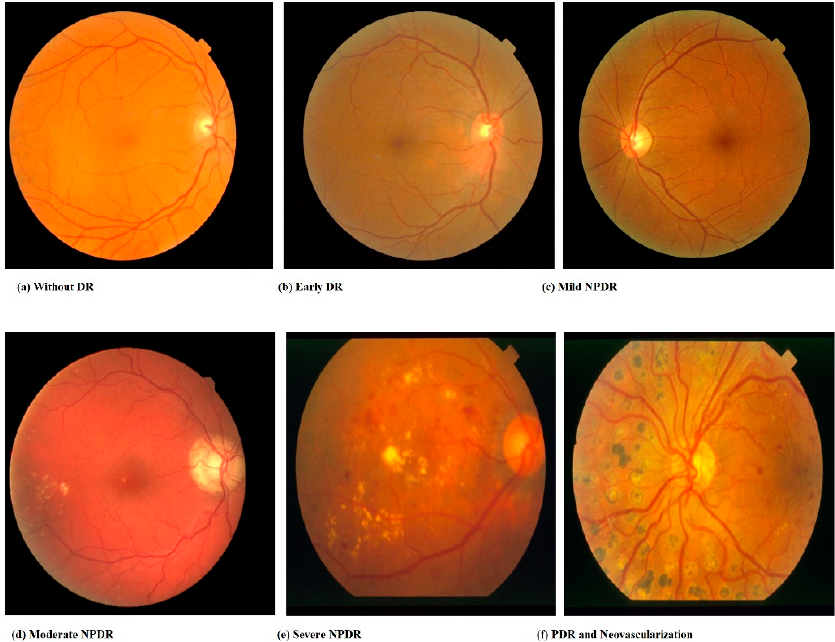
Figure 5. Classification of diabetic retinopathy.